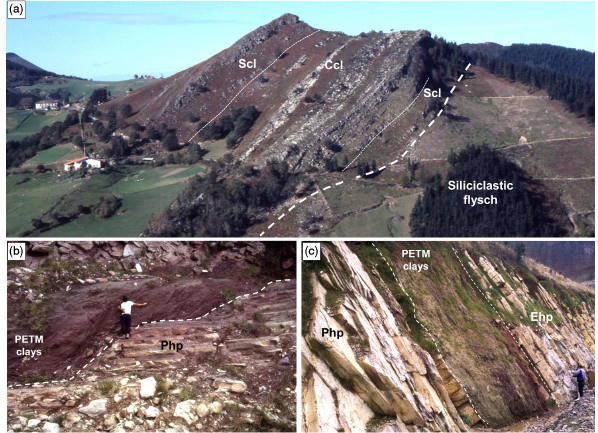
Figure 9. Field images of representative sections from the Gonzugaraia–Trabakua pass area (location in Fig. 8): (a) Gonzu- garaia, deep-sea channel bottom; (b) Trabakua pass west, deep-sea channel wall; (c) Trabakua pass east, basin floor.